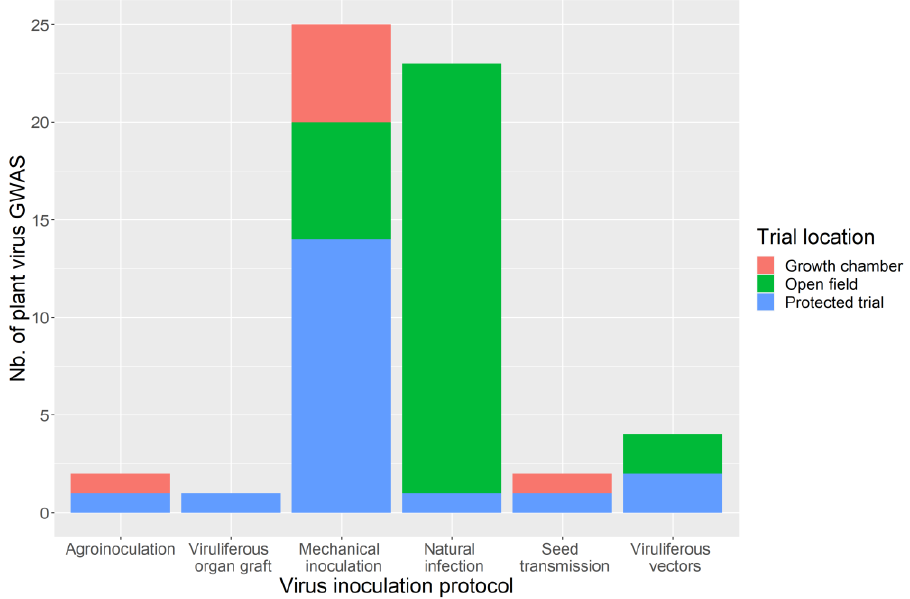
Figure 5. Number of plant virus GWAS regarding virus inoculation protocol and trial location. ‘Mechanical inoculation’ pools inoculations by hand rubbing and mist blower. ‘Protected trial’ pools plant virus GWAS trials which took place in greenhouses, glasshouses, and net protected fields.